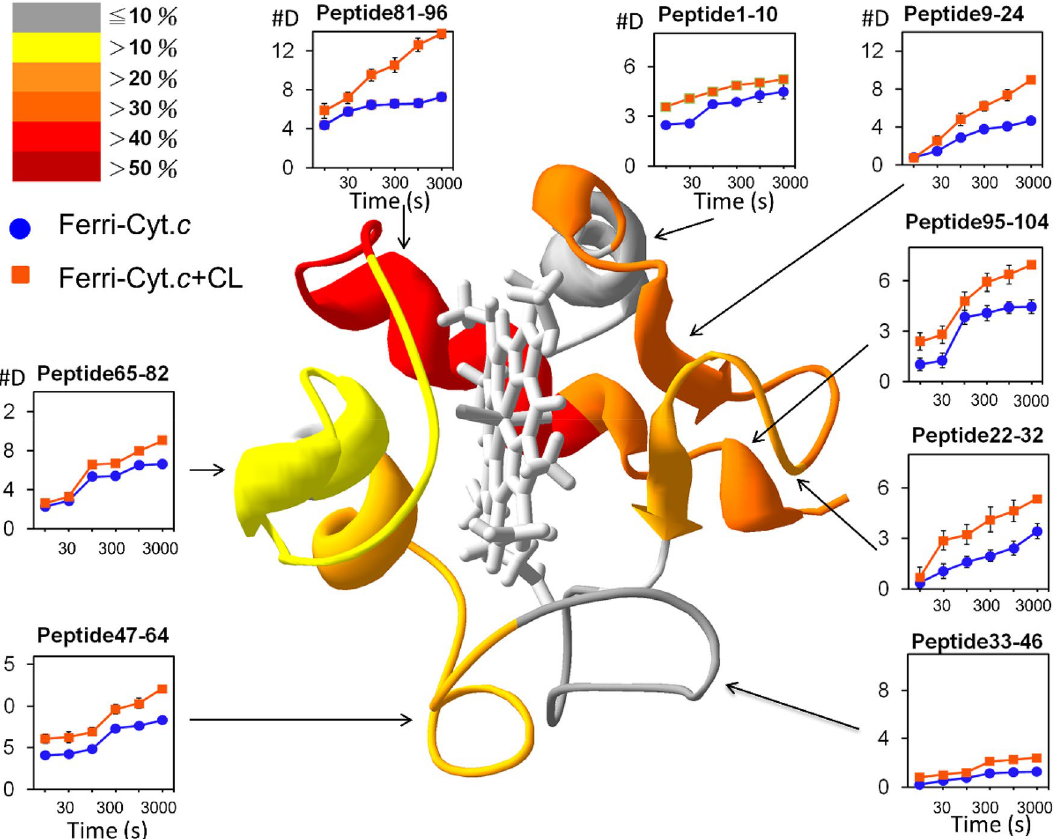
Figure 5. Deuteration level of ferric cyt c (blue) and the CL-bound ferric cyt c (orange) represented by peptide fragments. Enhancement of deuteration caused by CL binding is illustrated in percentages and displayed in different colors (scale shown in the top-left corner). The time-course deuterium number in each peptide fragment with the corresponding region of cyt c is presented (the ribbon diagram shown in the center of the